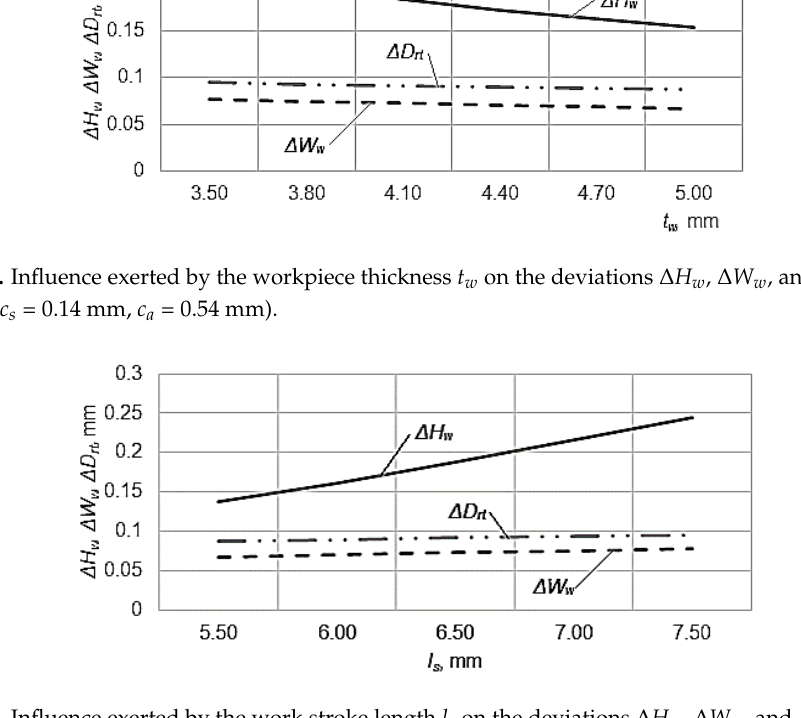
Figure 6. Influence exerted by the work stroke length l s on the deviations Δ H w , Δ W w , and Δ D rt ( t w = 4 mm, c s = 0.14 mm, c a = 0.54 mm).